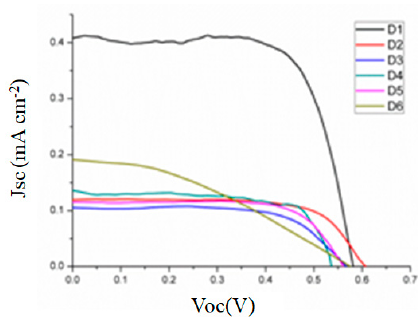
Table 5. Measured photovoltaic parameters of the fabricated DSSCs.